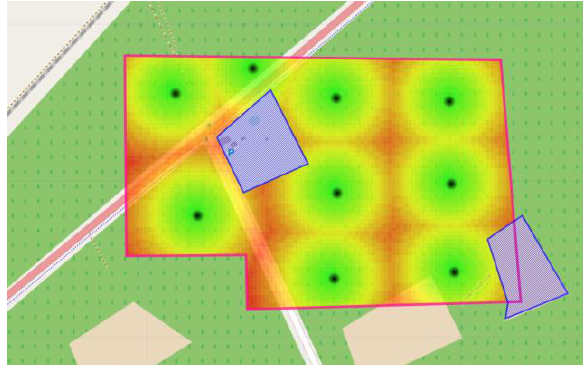
Fig. 7: Antenna positions and network coverage in a predefined area with